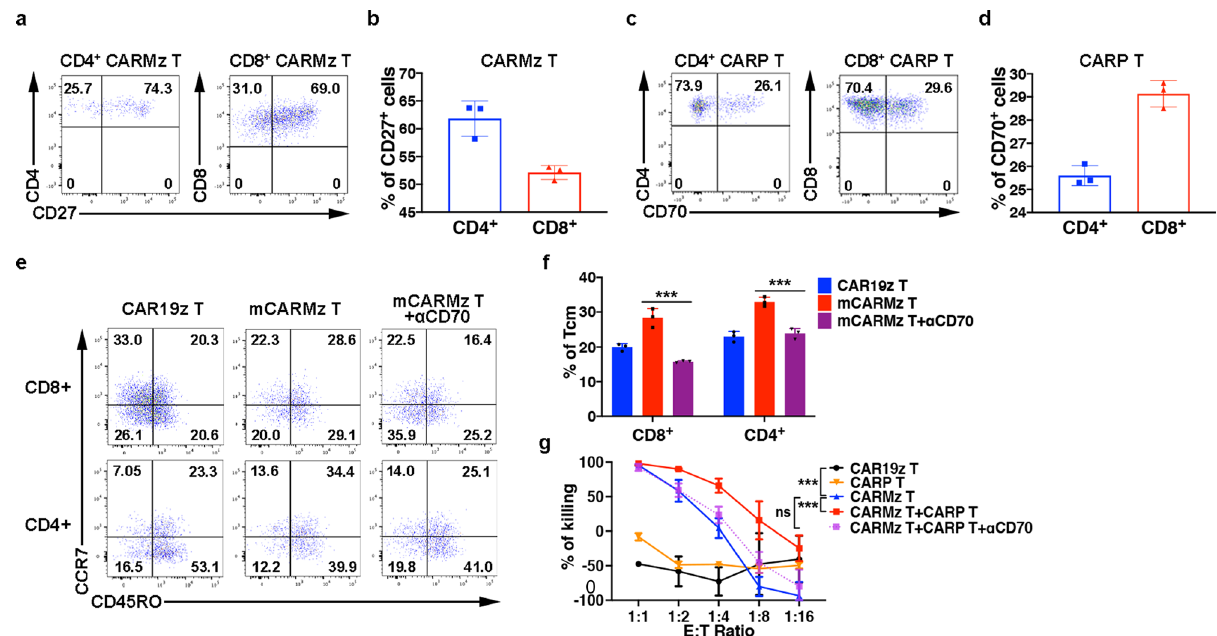
Fig.6|CARPTcellsaugmentstheef fi cacyandpersistenceofCARMzTcellsvia